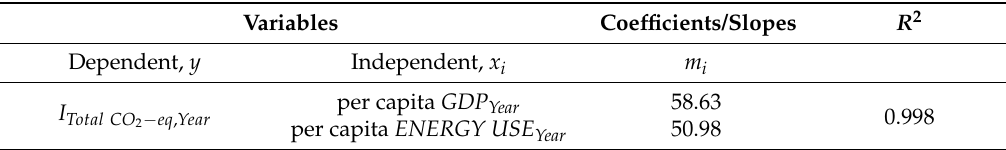
Table 4. Relationship between GHG emissions and socio-economic variables from 1970 to 2015. Variables Coefficients/Slopes R 2 Dependent, y